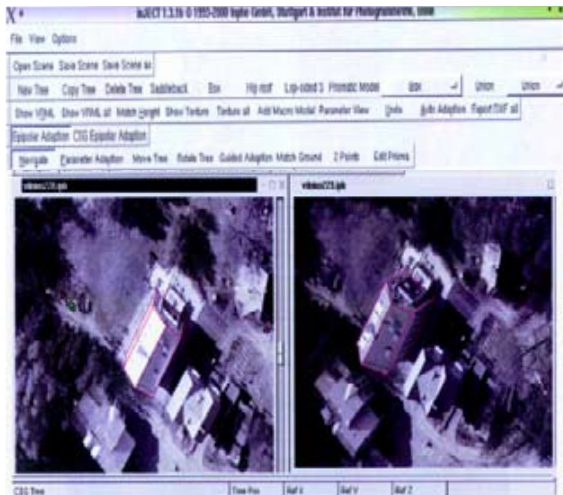
Fig 2. Fragment of building extraction by wire-frame adaptation method